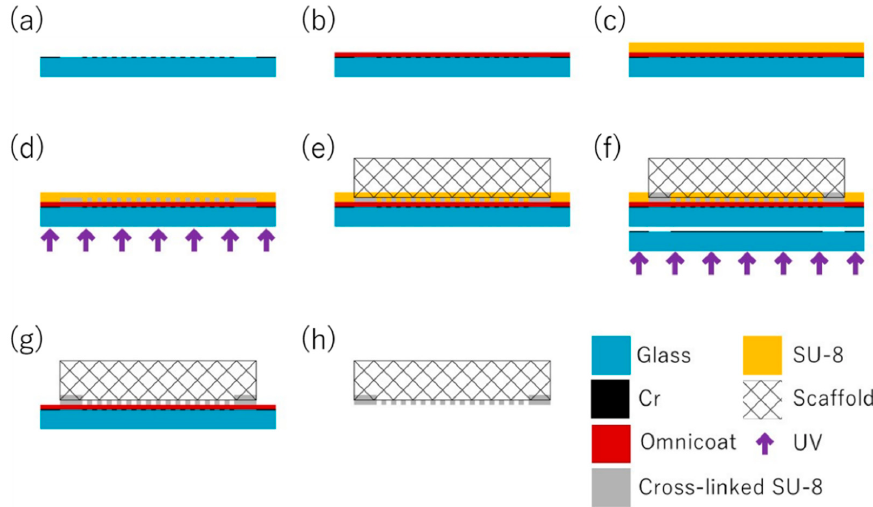
Figure 4. The fabrication process of the MIS. The MIS was fabricated by using the difference of the glass transition temperature between the exposed and unexposed areas of the thick-photoresist. First, the porous pattern was fabricated on the glass substrate by the Cr layer ( a ). The sacrificial layer was spin-coated on the substrate ( b ). SU-8 was spin-coated on the sacrificial layer ( c ). SU-8 was exposed from the backside of the substrate to the middle point of the SU-8 layer ( d ). The Alvetex scaffold was put on the SU-8 layer ( e ). The adhesion area was exposed from the backside of the substrate ( f ). The SU-8 layer was developed ( g ). Finally, the Alvetex scaffold adhered to the micropattern and was released from the substrate ( h ). As a preliminary treatment, the MIS was sterilized with ethanol and coated by a fibronectin. The fabricated MIS was sterilized with 78% ethanol. The 78% ethanol was then removed by phosphate buffered salts (PBS, T900, Roman Industries Co., Tokyo, Japan). The MIS was dipped into 10 mL PBS containing 1 μ L fibronectin (FC010, Merck KGaA, Darmstadt, Germany) for 30 min. The excess fibronectin was removed by dipping in pure PBS three times. The silicone rubber sheet, with a thickness of 1.5 mm and ϕ 4 mm hole, was set in the petri dish after it was sterilized with 78% ethanol. The MIS was placed on the silicone rubber sheet with the Alvetex scaffold side up. To lock the MIS, the poly dimethylpolysiloxane (PDMS) chip, the thickness of which was 3 mm with a ϕ 4 mm hole, was set on the MIS after it was sterilized with 78% ethanol. The ϕ 4 mm hole would work as a chamber for dropping cell suspension. HeLa cells were cultured in a petri dish with a diameter of ϕ 90 mm （ I-90-20, BIO-BIK). After the HeLa cells became confluent, the DMEM was removed. The HeLa cells were washed with 10 mL PBS, then 1 mL of cell releasing solution (0.25% tripsin-EDTA(1X), Waltham, MA, USA) was dropped into the petri dish. After 5 min incubation, the cell suspension was created by adding 9 mL DMEM. After cell suspension, the mixture was moved into a centrifuge tube, and it was centrifuged at 900 rpm for 3 min by a centrifugal separator (SRX-201, TOMY SEIKO Co., Ltd., Tokyo, Japan). After removing the supernatant, 1 mL of DMEM was added, then 300 μ L of the cell suspension was dropped on the Alvetex scaffold side of the MIS. After 2 mL of DMEM was added into the petri dish, the MIS was incubated for 24 h. After picking the MIS up from the silicone rubber sheet, the MIS was incubated for 20 days in another petri dish with 3.5 mL of DMEM.